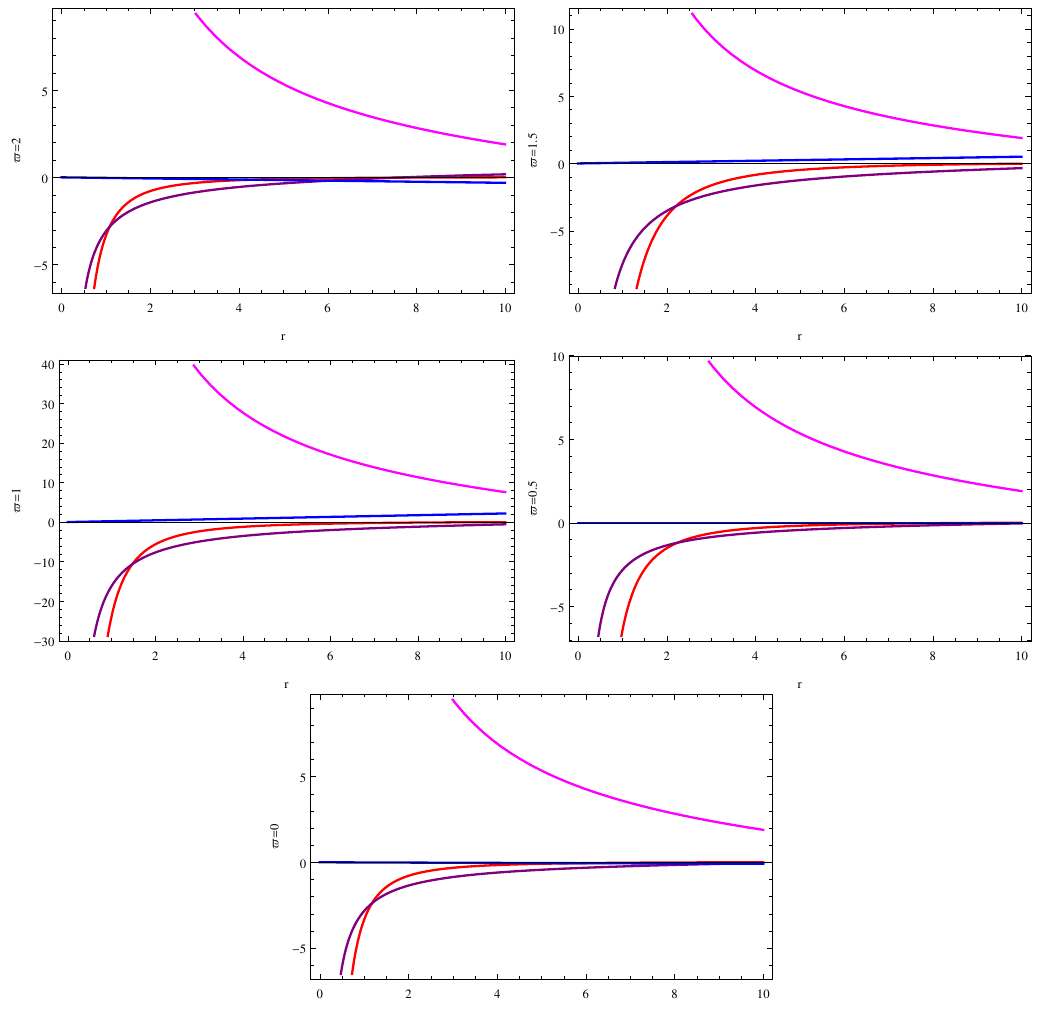
Figure 6. Plot of the different forces versus r for the strange star candidate LMC X − 4 due to different chosen values of (cid:118) . The red, purple, magenta, blue and black colors represent respectively F g , F h , F a , F e with (cid:118) = 0, (cid:118) = 0.5, (cid:118) = 1, (cid:118) = 1.5 and (cid:118) = 2 respectively.